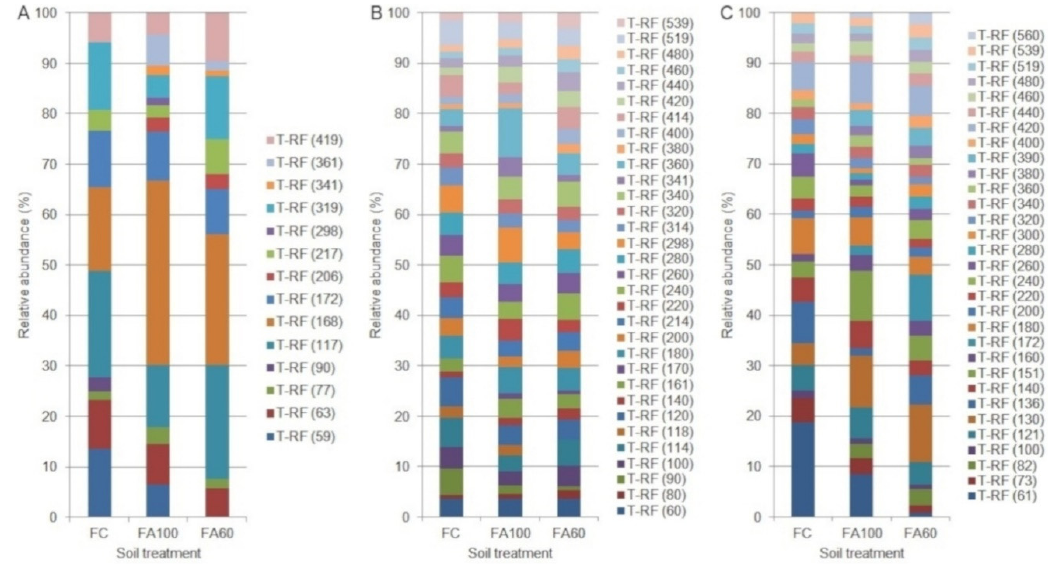
Figure 6. Relative abundance of the terminal restriction fragments obtained after HaeIII digestion for bacterial ( A ), archaeal ( B ) and fungal ( C ) communities in Abruptic Luvisol soil. Explanation: FC—optimal dose of fertilizer, FA100—optimal dose of fertilizer enriched with microorganisms, FA60—fertilizer enriched with microorganisms (dose reduced by 40%).